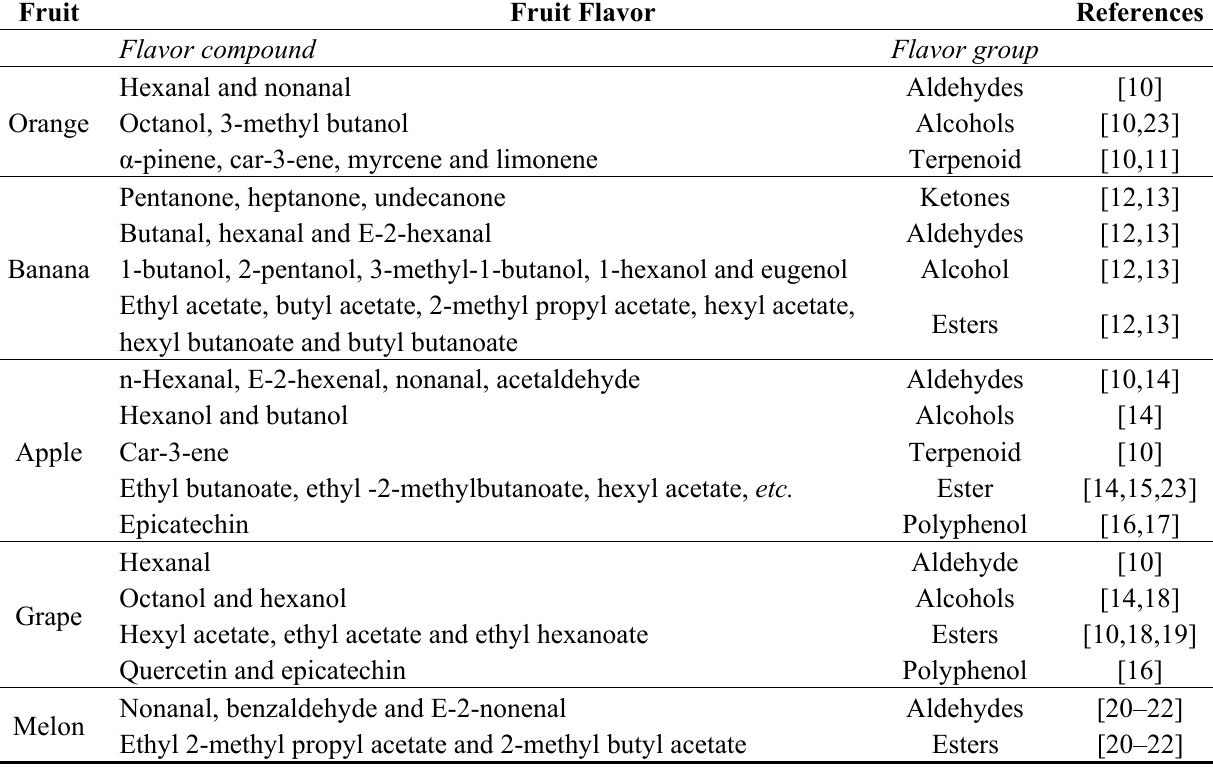
Table 1. Fruit flavors in some